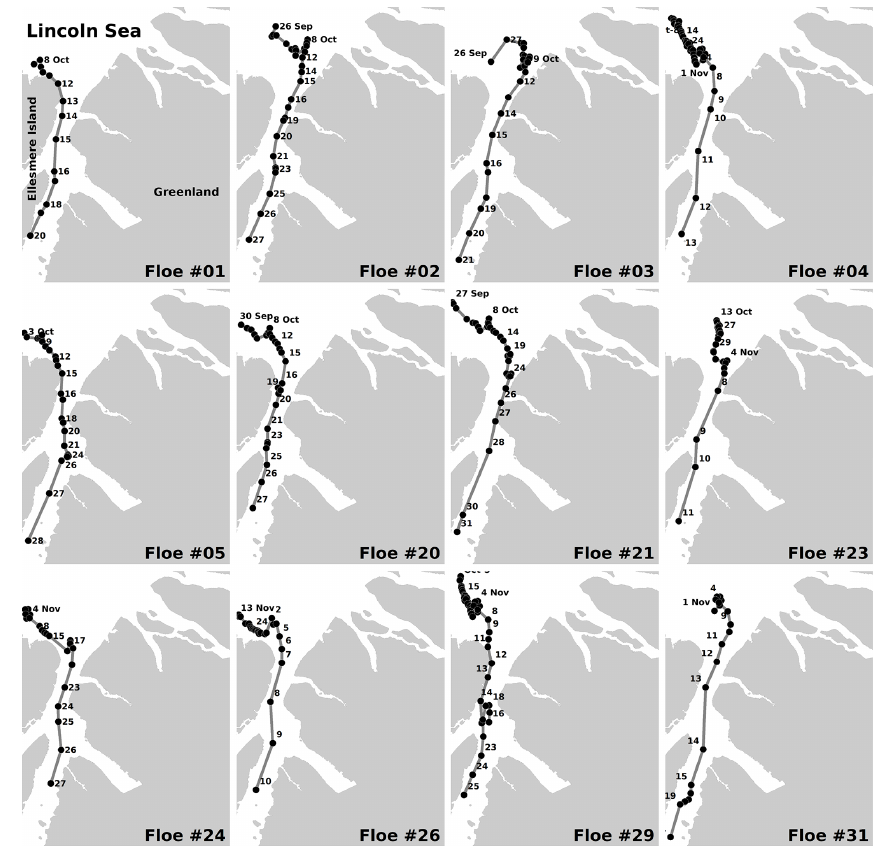
Figure 4. Trajectories of 12 selected ice floes, obtained from the daily Sentinel-1 images, as they approach and pass through the Robeson Channel. Note the slow motion upstream of the channel and the faster motion through the channel. The entrance to the channel is marked by the solid line in the top left